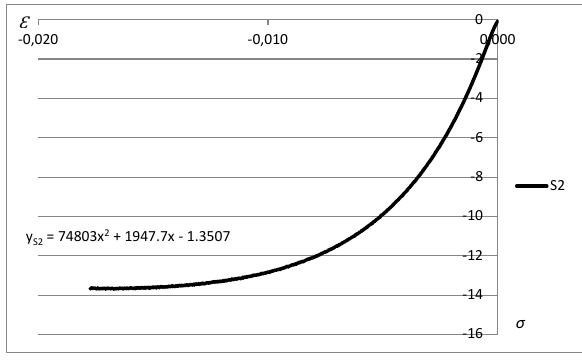
Figure 9: Dependence σ on C2S2 adhesive, as function S2 under